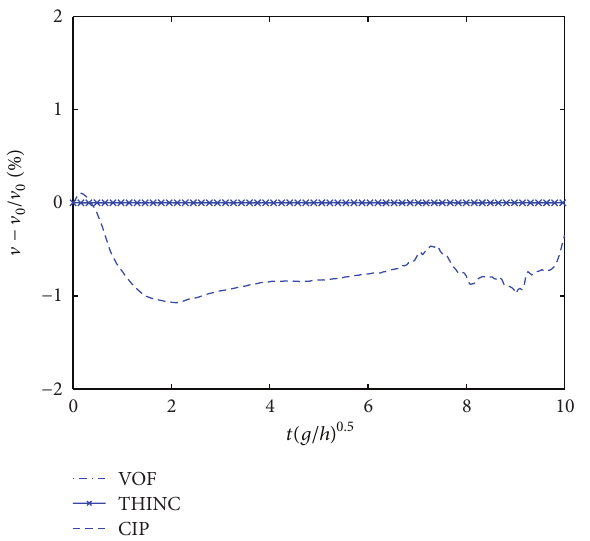
Figure 11: Time history of the water front toe 𝑥